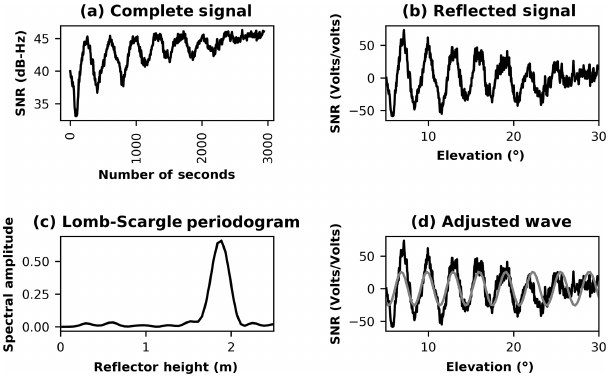
Figure 7. GLONASS satellite no. 5 observed with the geodetic an- tenna. SNR data in volts (a) , SNR data with the direct signal re- moved (b) , Lomb–Scargle periodogram for the SNR reflected sig- nal (c) , and SNR reflected signal with the adjusted wave (d) .